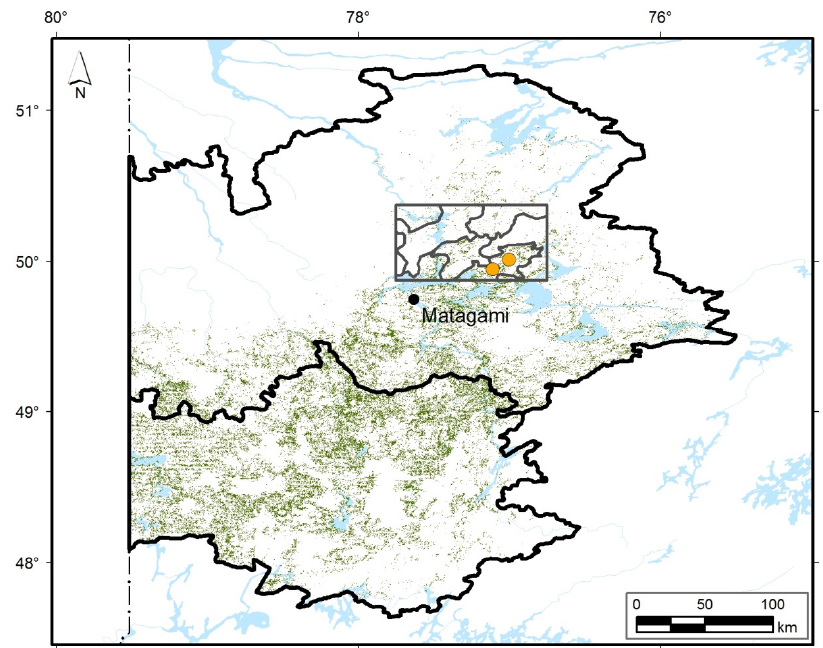
Figure 9. Forest stands dominated by Populus tremuloides on clay ( green ) in ecological region 6a-Plaine du lac Matagami ( Picea mariana -moss domain, upper part) and 5a-Plaine du lac Abitibi ( Abies balsamea-Betula papyrifera domain, lower part). The study area (rectangle), the landscapes delineated in this area ( n = 8) and the two studied peatlands ( orange points) are